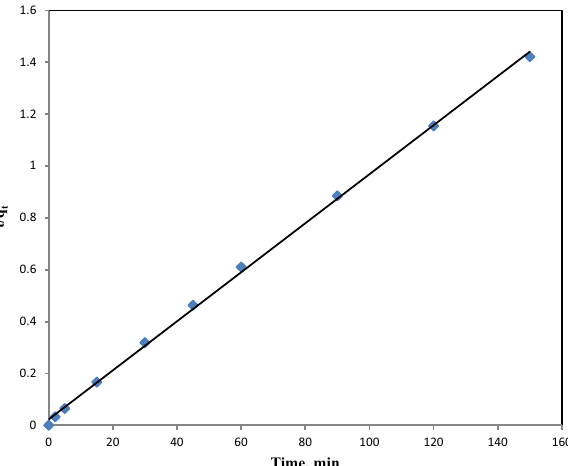
Figure 9. The linearized PSO biosorption dynamics of